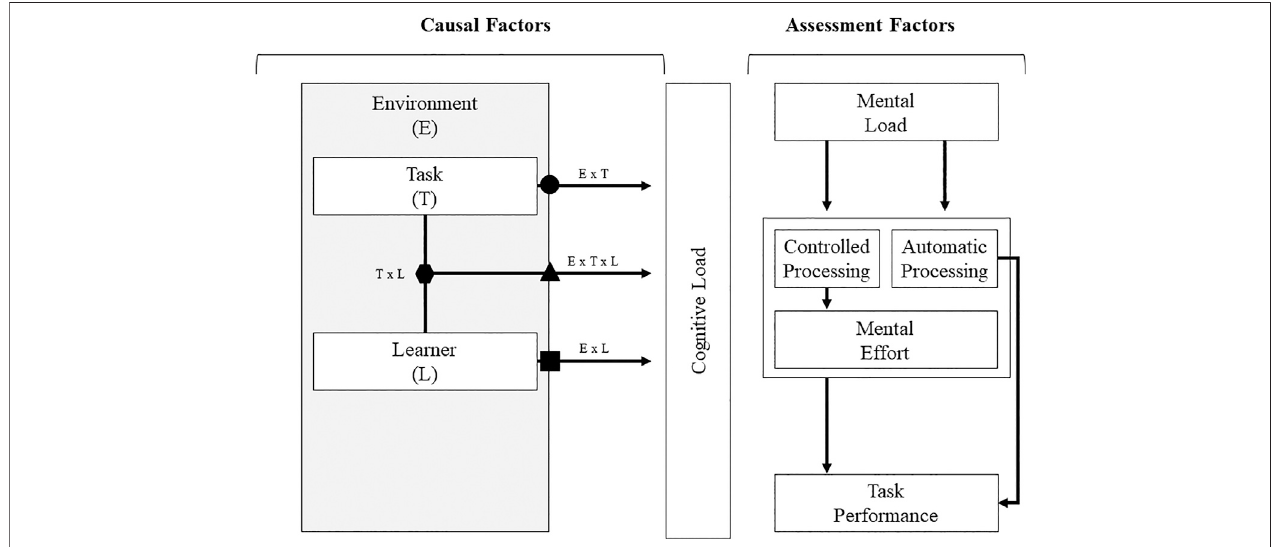
FIGURE 1 | Cognitive load as re fl ected by causal factors and assessment factors, including two- and three-way interactions between the causal factors (adapted from Choi et al., 2014, p. 229).